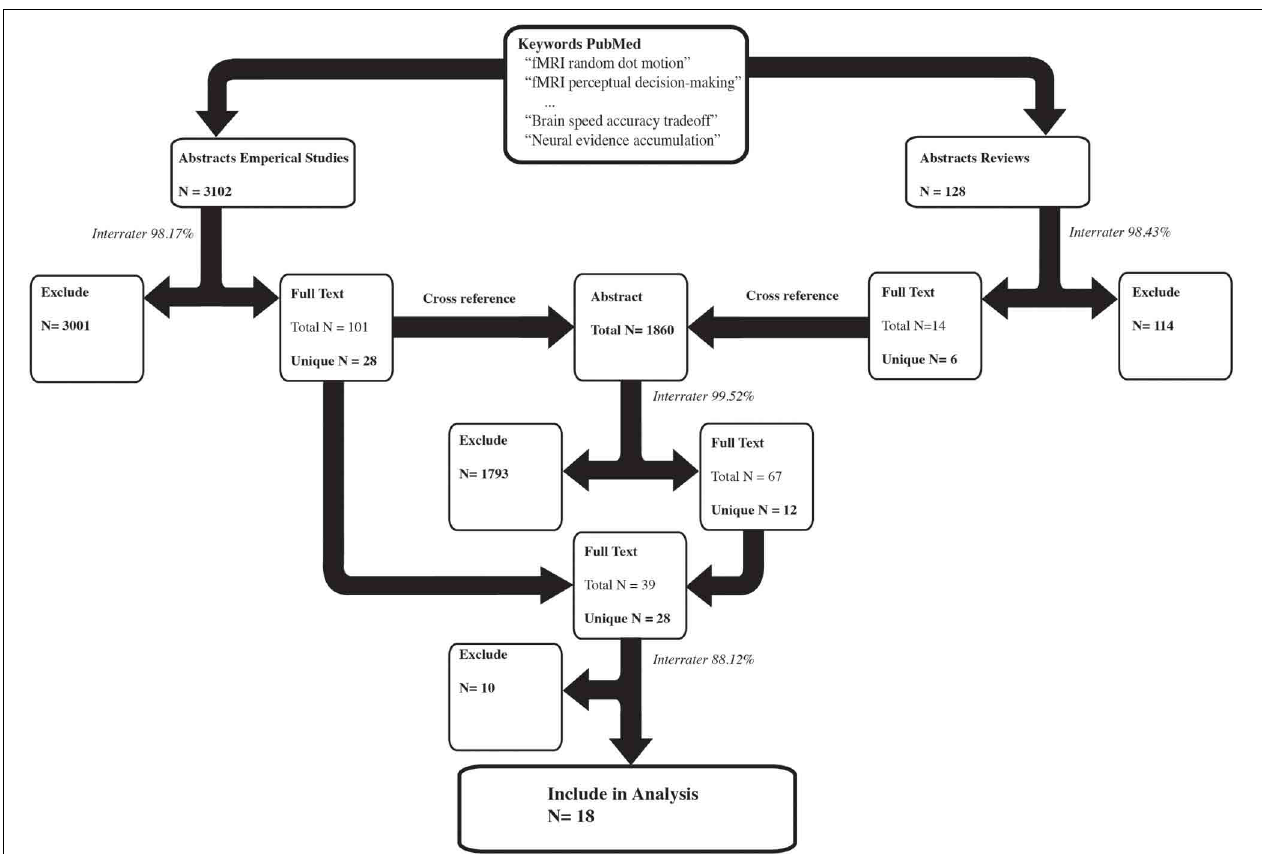
FIGURE 1 | The selection procedure for the inclusion of empirical studies. The left arm shows the selection process of the empirical studies based on the abstracts. The right arm shows the selection process of the review papers based on the abstracts. The number of results per selection stage is reported in bold. Several keywords resulted in the inclusion of the same study, which is reflected by the total N. Subsequently only the unique